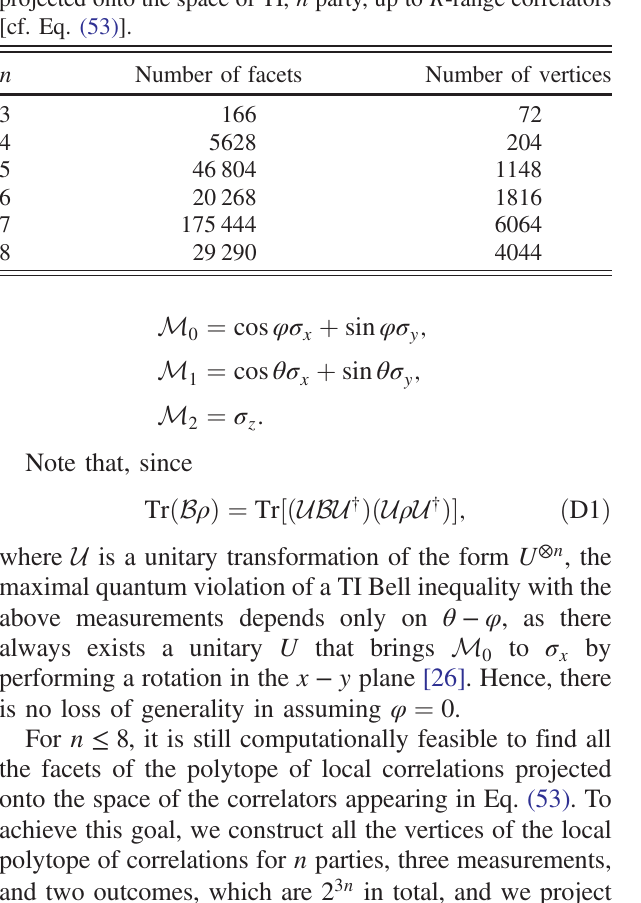
TABLE II. Classes of inequalities of the form of Eq. (53) that are violated for different n with the same set of measurements at each site. We present one representative per class; the rest can be found by applying a suitable symmetry such as a renaming of the measurements, outcomes, and/or parties [38]. The γ ’ s constitute the coefficients of the Bell inequality, β the quantum violation achieved with the measurement settings defined through φ 0 and φ 1 . Note that due to Eq. (D1), this depends only on φ 1 − φ 0 (recall that the measurement settings we use parametrize the quantum observables as M ð i Þ we omit the index i because we are in the TI